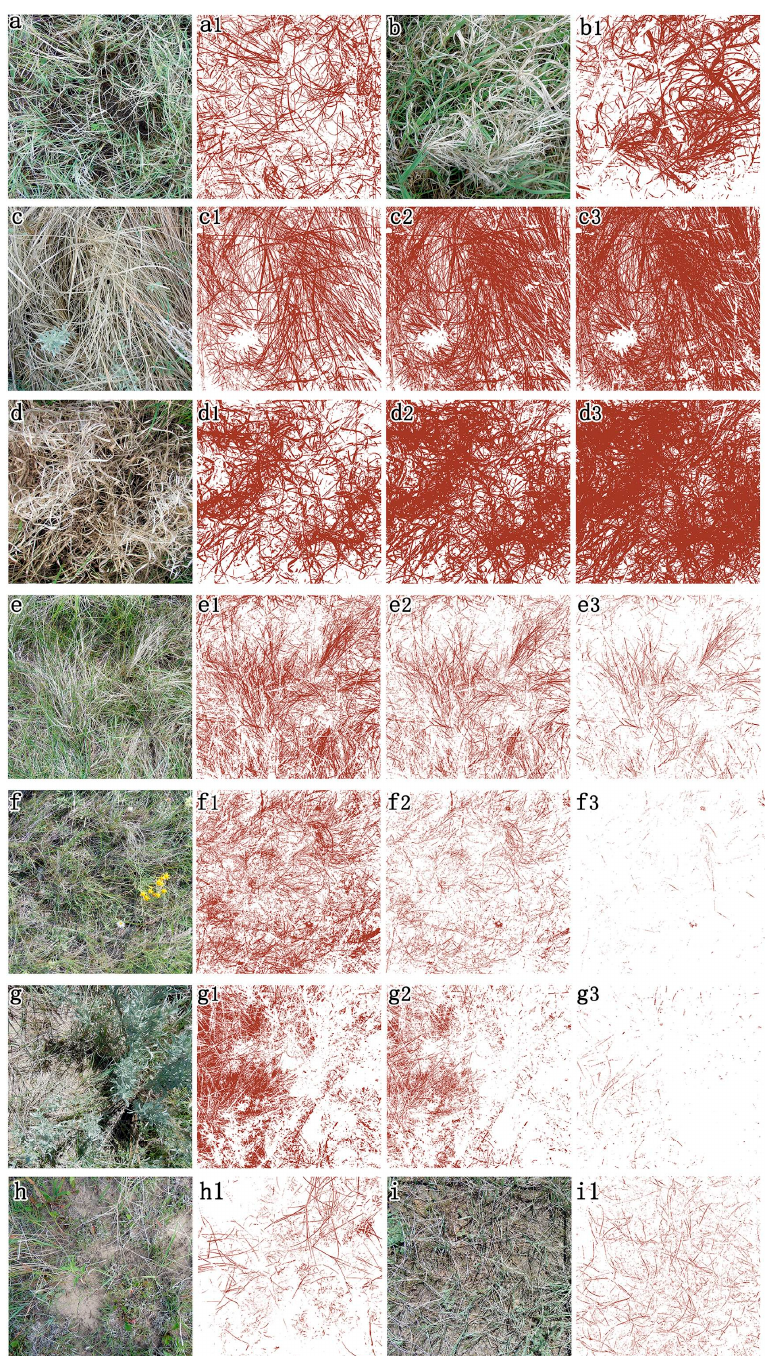
Figure 3. ExtractedSDMfromfield-takenRGBimages. ( a )RGBimagetakeninvalleygrassland. ( a1 )extraction of standing dead matter (SDM) from ( a ) with d = 1. ( b ) RGB image taken in disturbed communities. ( b1 ) Extraction of standing dead material from (b) with d = 1. ( c ) RGB image taken in valley grassland. ( c1 – c3 ) Extraction of SDM from ( c ) with d = 1, 0.7, 0.5, respectively. ( d ) RGB image taken in sloped grassland. ( d1 – d3 ) Extraction of SDM from ( d ) with d = 1, 0.7, 0.5, respectively. ( e ) RGB image taken in sloped grassland. ( e1 – e3 ) Extraction of SDM from ( e ) with d = 1, 1.2, 1.5, respectively. ( f ) RGB image taken in upland grassland. ( f1 – f3 ) Extraction of SDM from ( f ) with d = 1, 1.5, 2, respectively. ( g ) RGB image taken in valley grassland. ( g1 – g3 ) Extraction of SDM from ( g ) with d = 1, 1.5, 2, respectively. ( h ) RGB image taken in disturbed communities. ( h1 ) Extraction of SDM from ( h ) with d = 1.5. ( i ) RGB image taken in valley grassland. ( i1 ) Extraction of SDM from ( i ) with d =